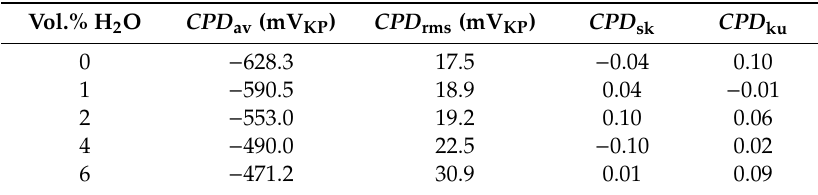
Figure 5. Contact potential difference ( CPD ) maps for the AISI 1010 steel electrodes after 96 h of immersion in sulfolane containing 0 ( a ), 1 ( b ), 2 ( c ), 4 ( d ) and 6 ( e ) vol.% of water; V KP is the voltage measured versus Kelvin probe. Table 2. Statistical parameters calculated using maps shown in Figure 5; CPD av is the average value, CPD rms is the root mean square deviation, CPD sk is the skewness and CPD ku is the kurtosis; V KP is the voltage measured versus Kelvin probe.